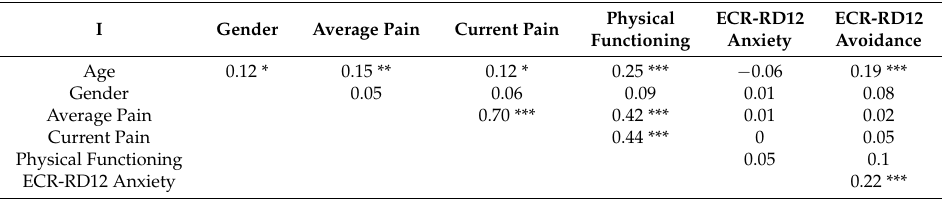
Table 3. Correlations among core study variables, n =